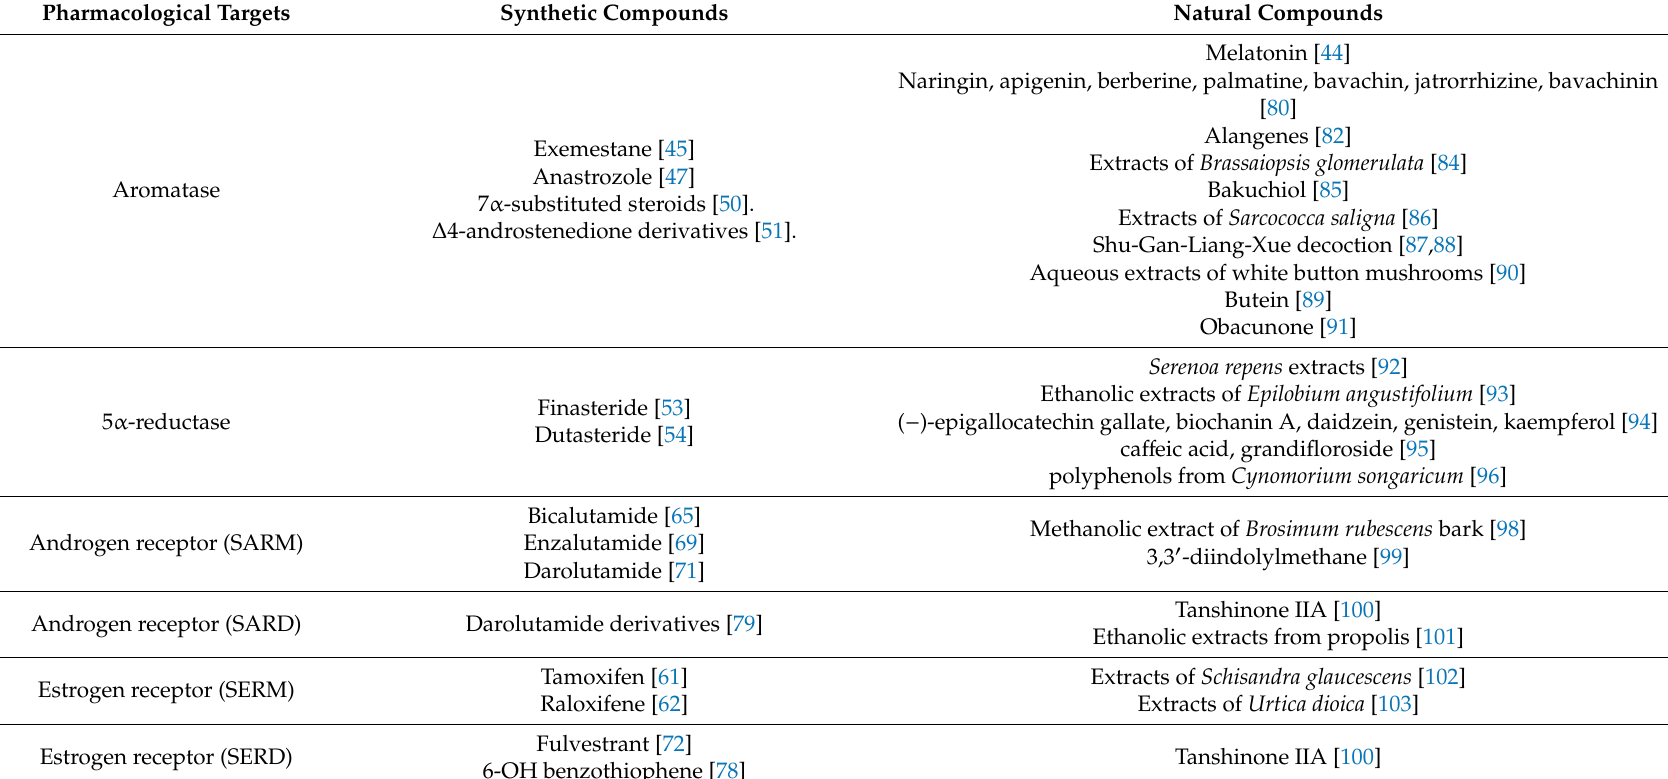
Table 1. Examples of molecules for the synthesis and activity of androgens and